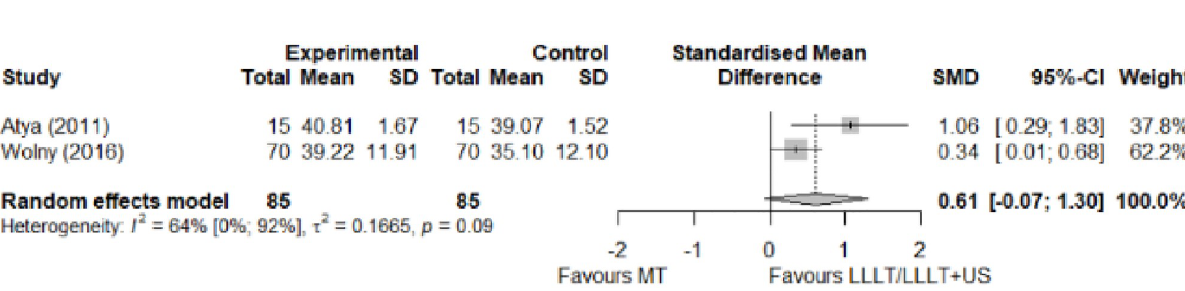
Fig 17. Analysis—Electrophysical modalities versus manual therapy (motor latency). Studies delivering modalities with a splint were marked as (SP).